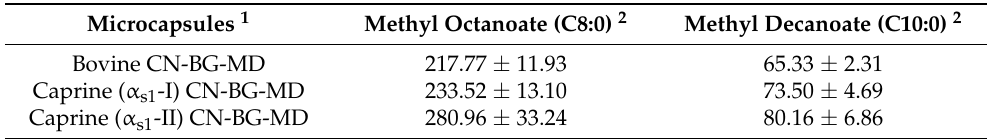
Table 6. Composition ( µ g/ µ L) of fatty acid methyl esters from lutein microcapsules at week 6 (at 40 ◦ C and 32% relative